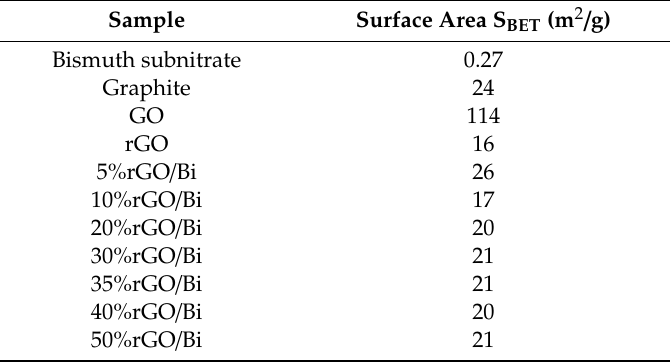
Table 1. Textural properties of the studied